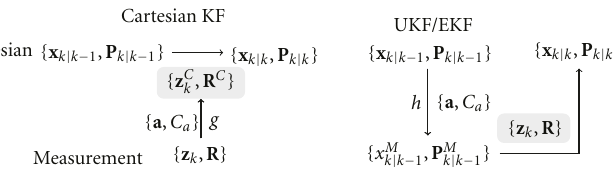
Figure 7: Track update schemes: Cartesian KF (left): Transformation of measurement z k into Cartesian state; UKF/EKF (right): Transformation of predicted track state into measurement space.